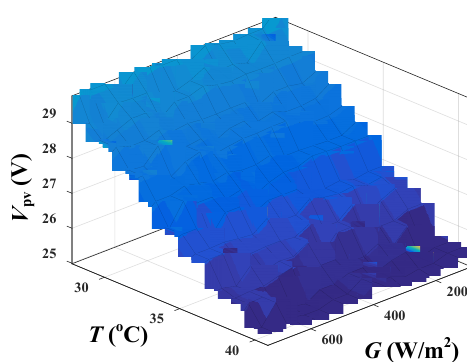
Figure 4. MPP voltage at various G and T